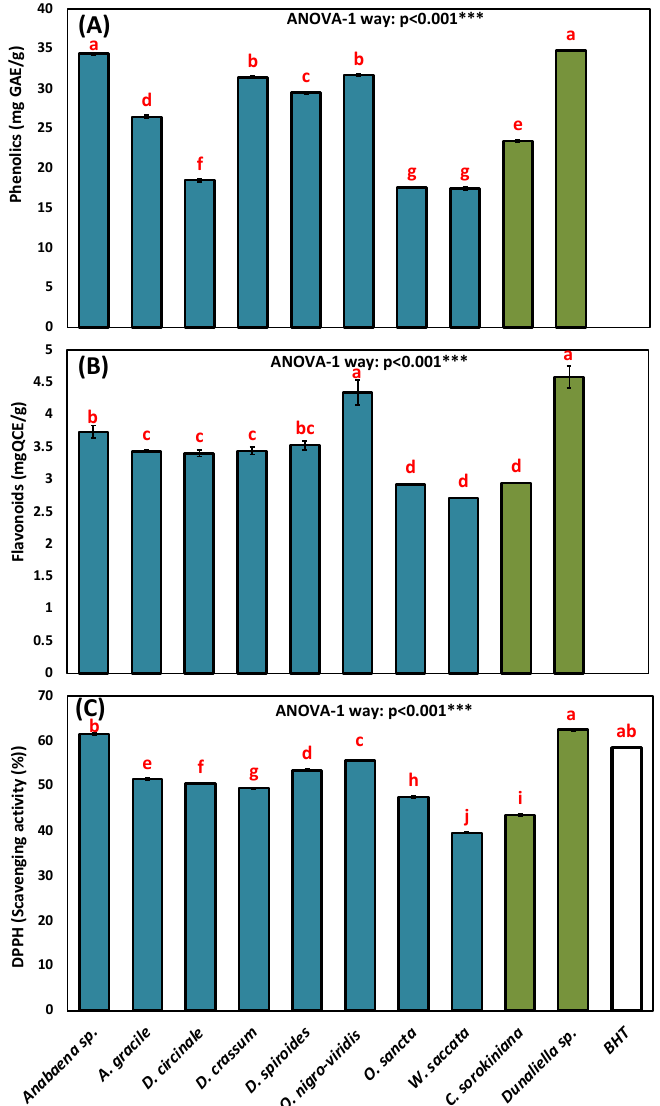
Figure 3. Average concentrations of the total phenolics ( A ), flavonoids ( B ), and DPPH ( C ) of the different cyanobacterial and algal strains investigated in the present study. Bars with different superscript letters were significantly different according to DMRT at p < 0.05. *** significant at p < 0.001.